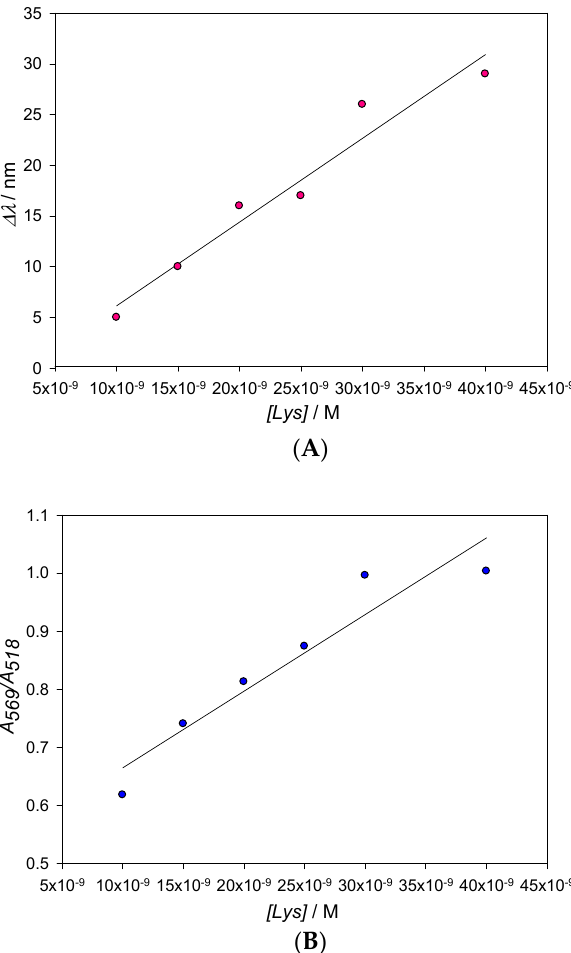
Figure 5. Changes of the maximum of the SPR ( A ) and the A 569 /A 518 ratio ( B ) with Lys concentration. From Figure 5A, a value of 1.3 × 10 − 9 M for the detection limit (L.D) has been obtained, with L.D. = 3S/D being D the slope of the line and S the standard deviation of the measurements.